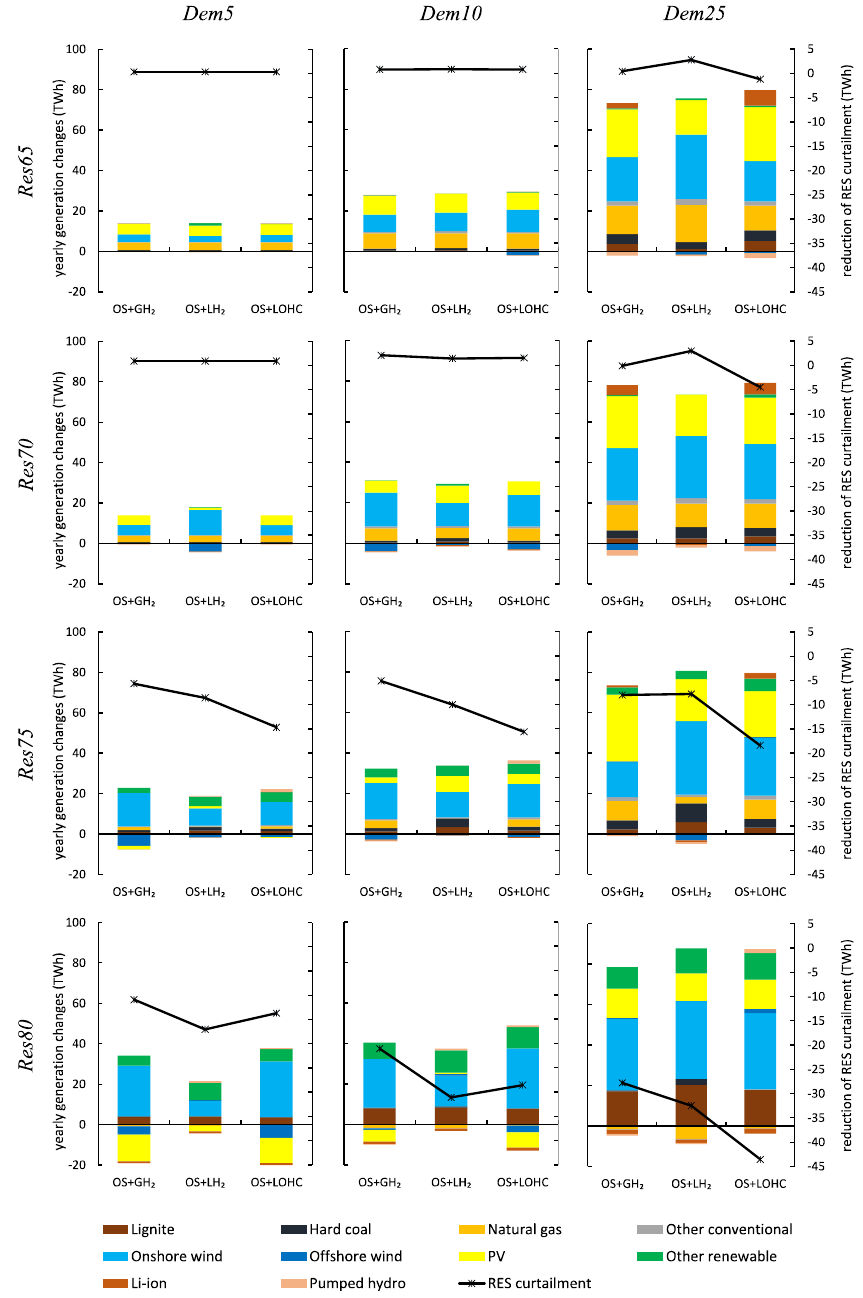
Figure 6. Yearly electricity generation changes compared to the respective baselines without hydrogen for optimal combinations of small-scale and large-scale hydrogen supply chains as shown in Fig.